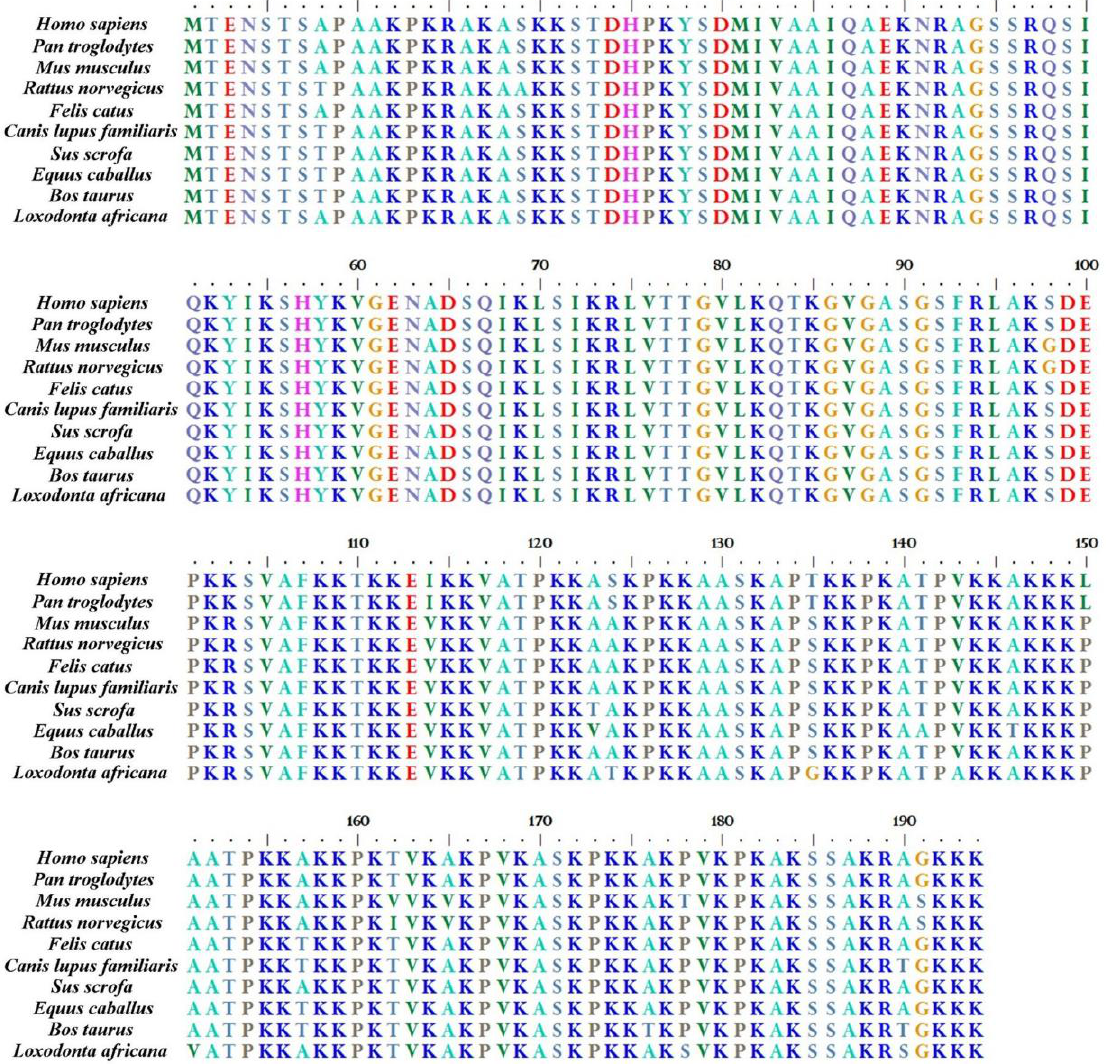
Figure 2 – Alignment of H1.0 histones in different mammalian species. NCBI reference sequences reported: Homo sapiens (NP_005309.1); Pan troglodytes (XP_009436643.1); Mus musculus (NP_032223.2); Rattus norvegicus (NP_036710.1); Felis catus (XP_006934092.1); Canis lupus fam. (XP_005625954.1); Sus scrofa (XP_003126085.1); Equus caballus (XP_005606674.1); Bos taurus (NP_001069955.1); Loxodonta africana (XP_010597636.1). Alignment of the shown sequences has been done by Bioedit sequence alignment editor [74].